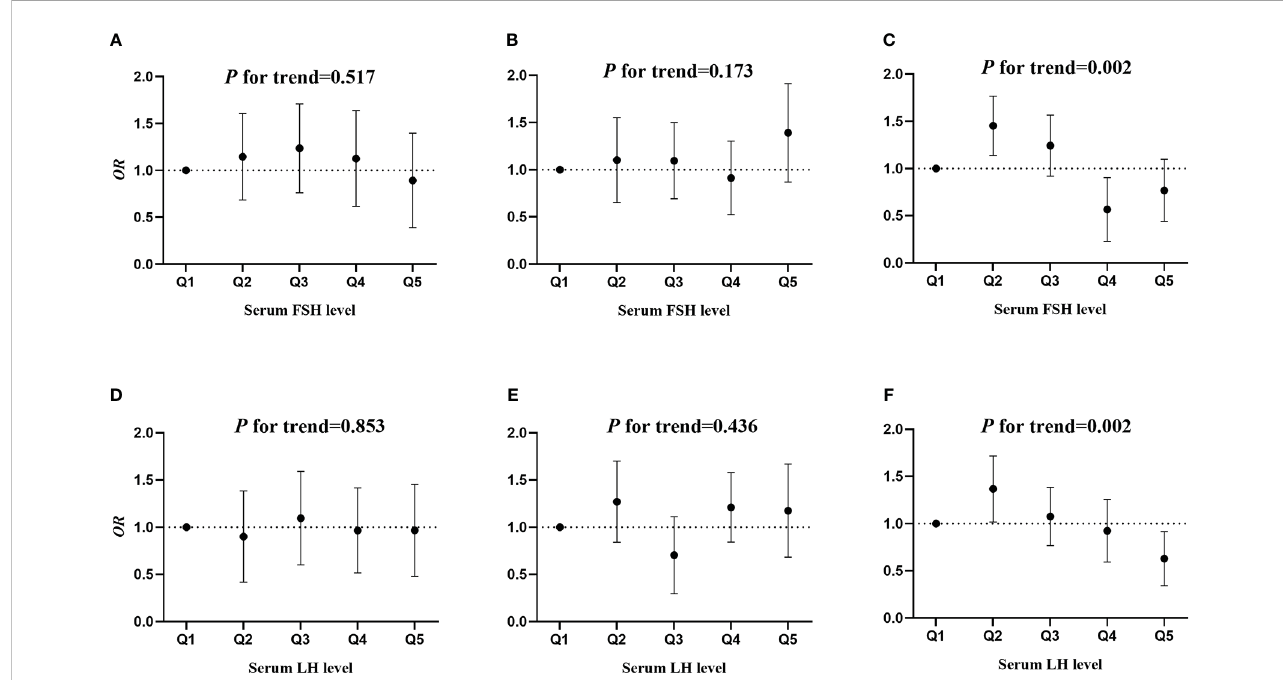
FIGURE 2 The associations of serum FSH and LH quintiles with the risk of MetS. (A, D) premenopausal women, (B, E) perimenopausal women, and (C, F) postmenopausal